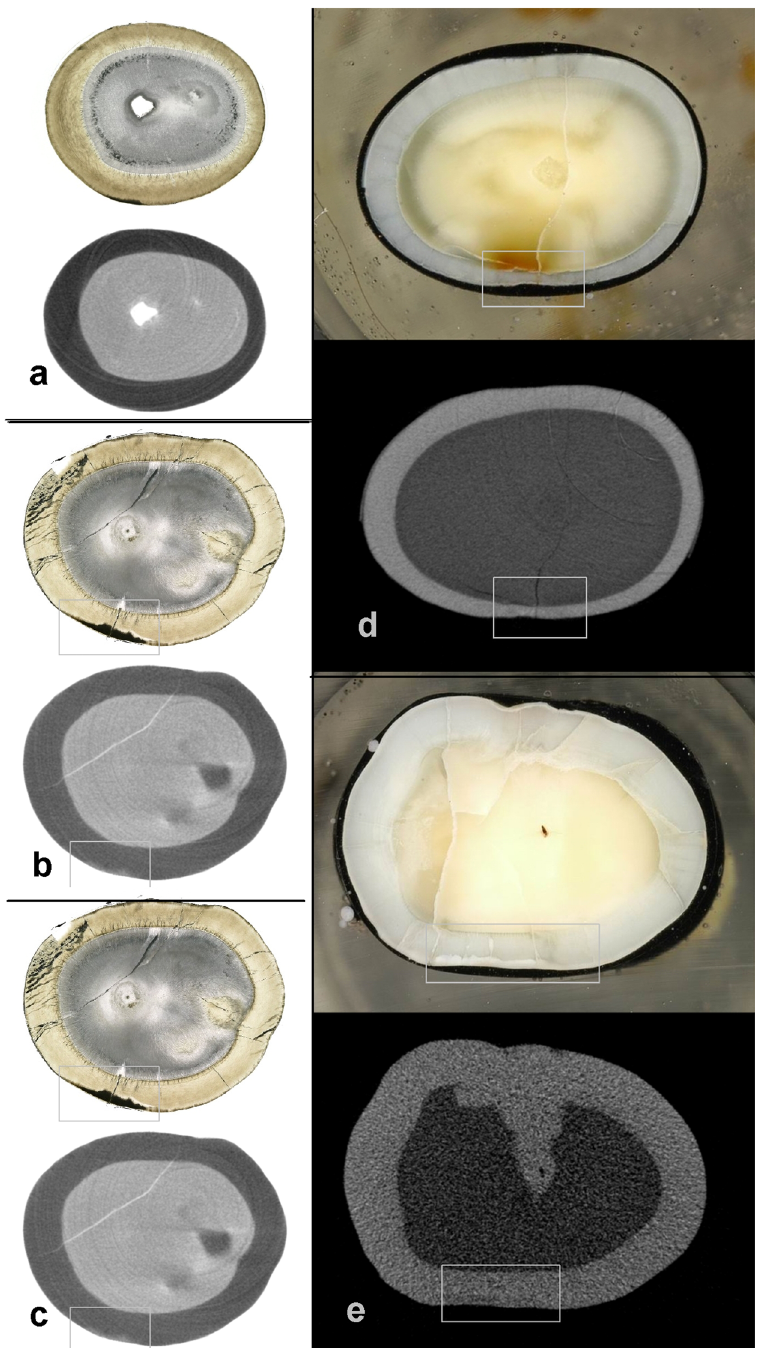
Figure 3. Exemples of histological or micro-CT images showing agreement or disagreement between histology or micro-CT scored unanimously by all 4 observers.. Agreement, (a: sound, b: enamel caries, c: dentine caries), disagreement is shown in image d: higher score in histology than in micro-CT and e: higher score in micro-CT compared to